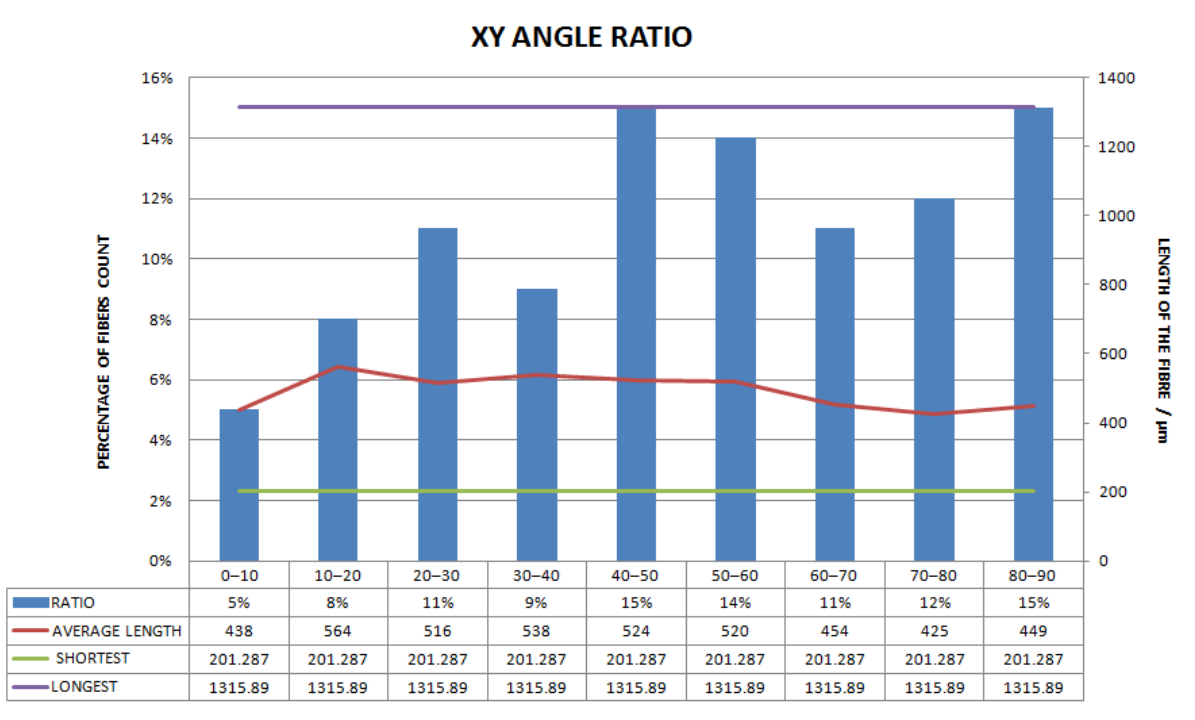
Figure 13. Statistical diagram of the angle between a polyester short fiber reconstructed by Avizo software and the XY direction (less than 200 microns removed).